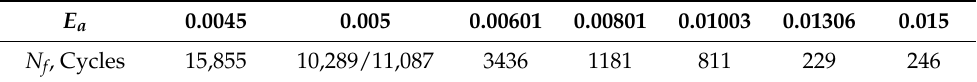
Table 2. Experimental fatigue lives data of GH4169 at 500 ◦